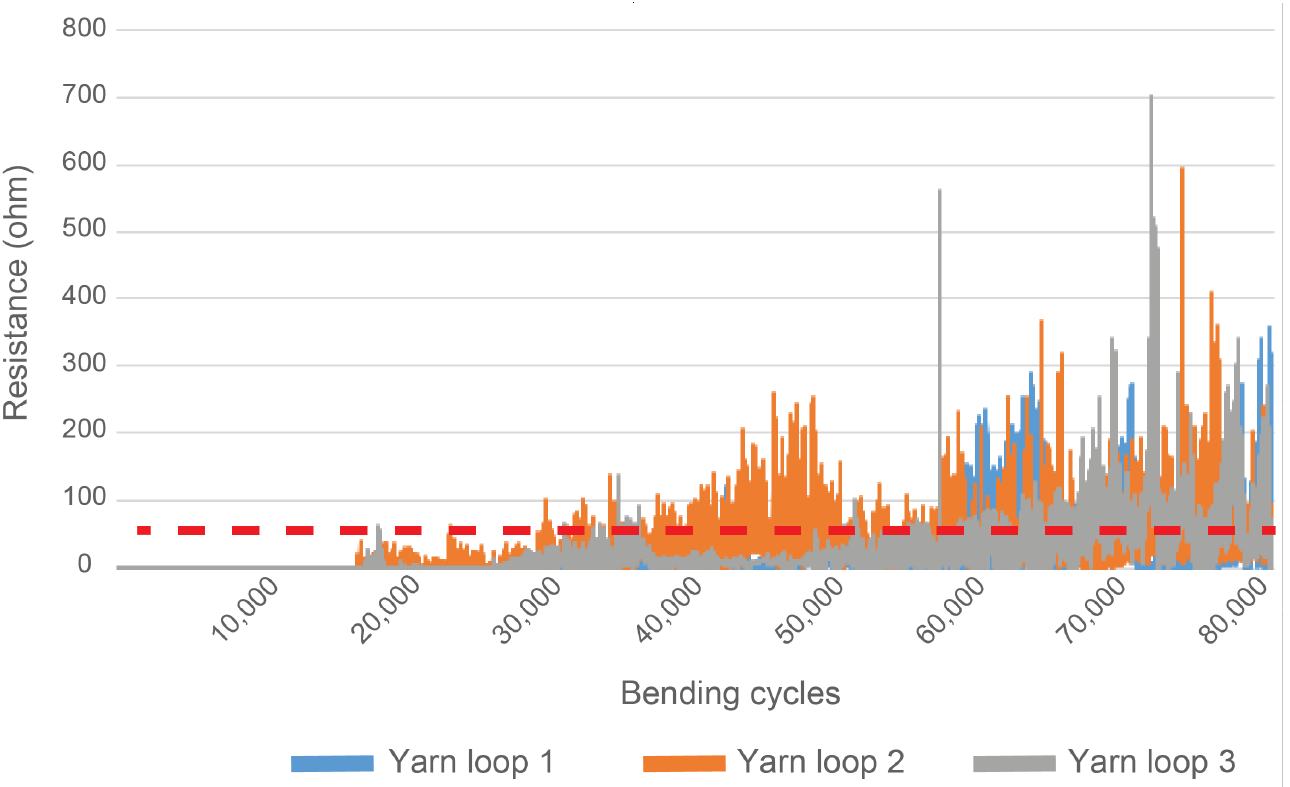
Figure 3. Results of Yarn 1 from sample set 1 (Ni-plated copper yarn) with the red dotted line highlighting the failure points. The figure visualises the whole test of one of the samples to provide an understanding of how the resistance changed over during the test.